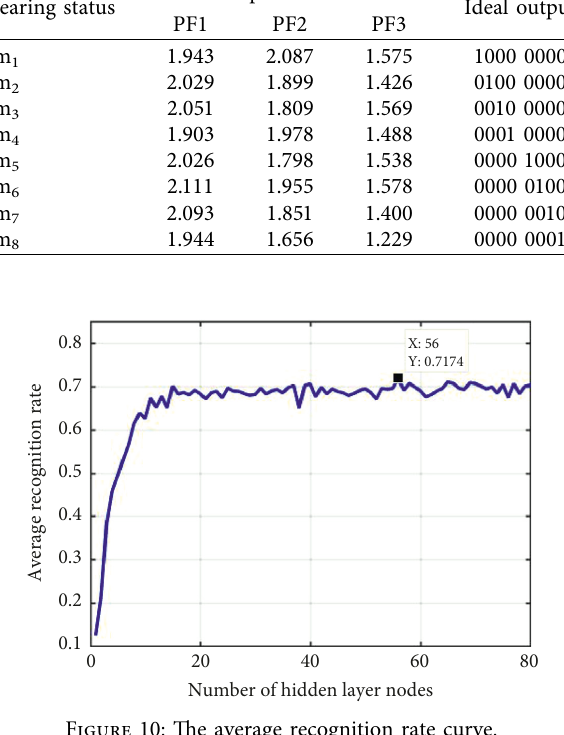
Table 3: The first 3 PF symbol entropy of 8 states of bearings. bearing status